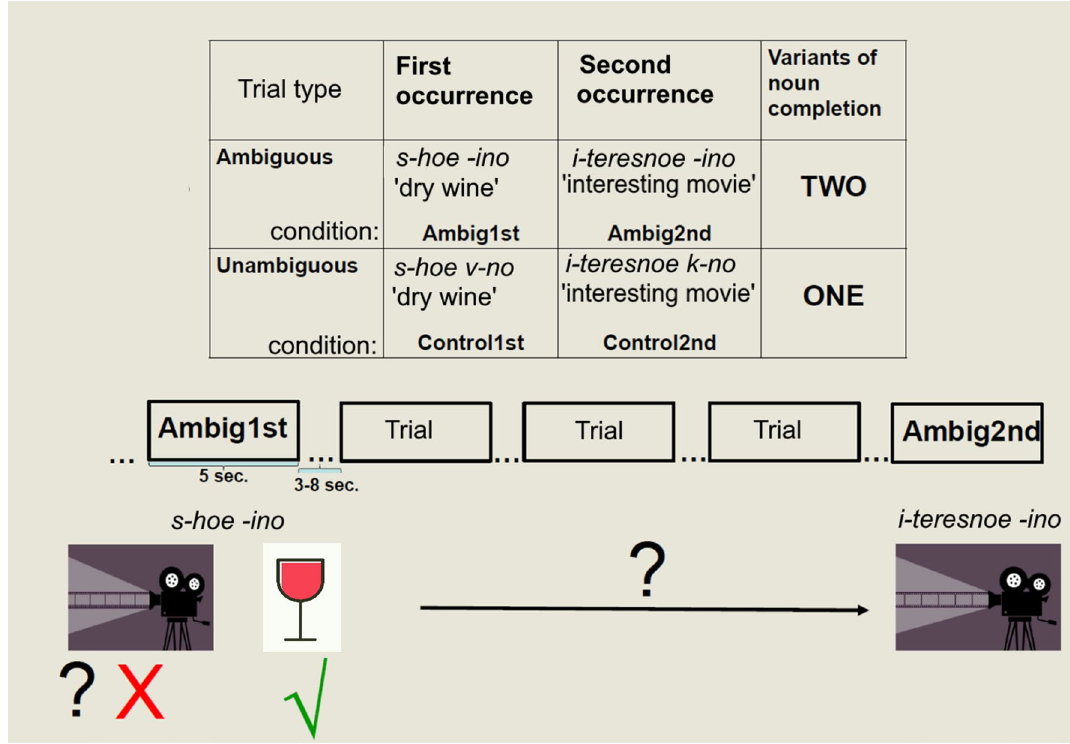
Figure 1. The experimental design of the fMRI study. The table illustrates four different trial types. The pictures in the lower part illustrate two variants of completion of the noun -ino ( vino ‘wine’ or kino